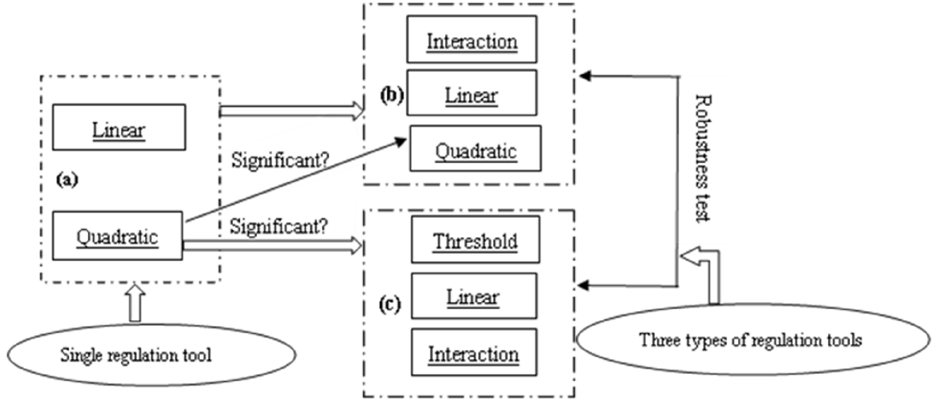
Figure 1. Research framework: (a) Do linear and quadratic effects of a single regulatory tool hold true?; (b) Whether interaction effects of different regulatory tools are significant (in the framework of linear and quadratic effects, only containing regulatory tools that pass the quadratic significance test)?; (c) Whether threshold effects of regulatory tools with quadratic effect are significant (in the framework of linear and interaction effect s) ?.